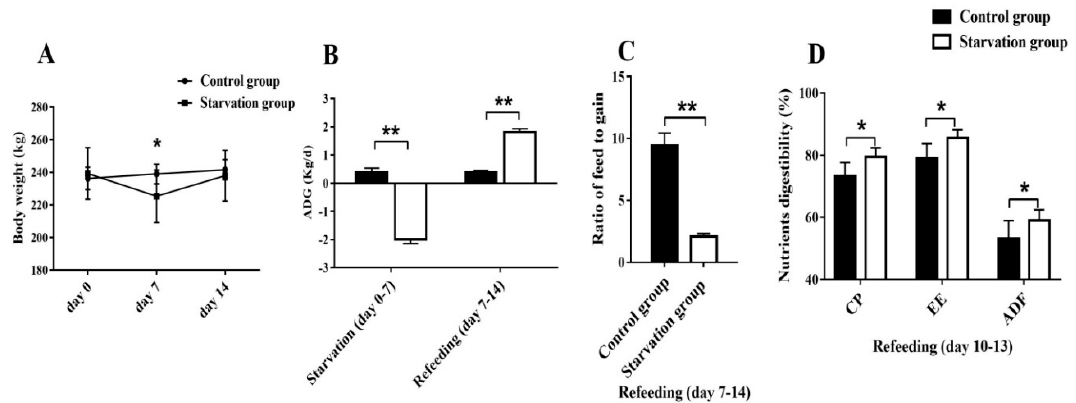
Figure 1. Effects of starvation and refeeding on the growth performance and nutrient digestibility of yaks. Comparisons of the body weight ( A ), ADG (average daily gain) ( B ), F/G (the ratio of feed to gain) ( C ) and nutrient digestibility ( D ) between the starvation and control groups. Values are means ± SD ( n = 6). Differences were represented by * p < 0.05 and ** p < 0.01.